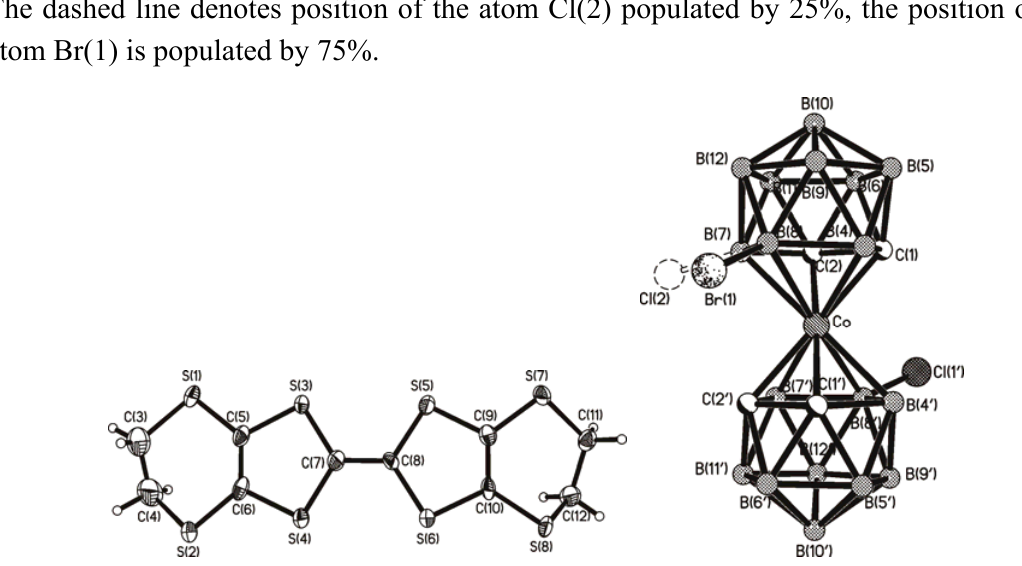
Cl -3,3'-Co(1,2-C 0.75 1.25